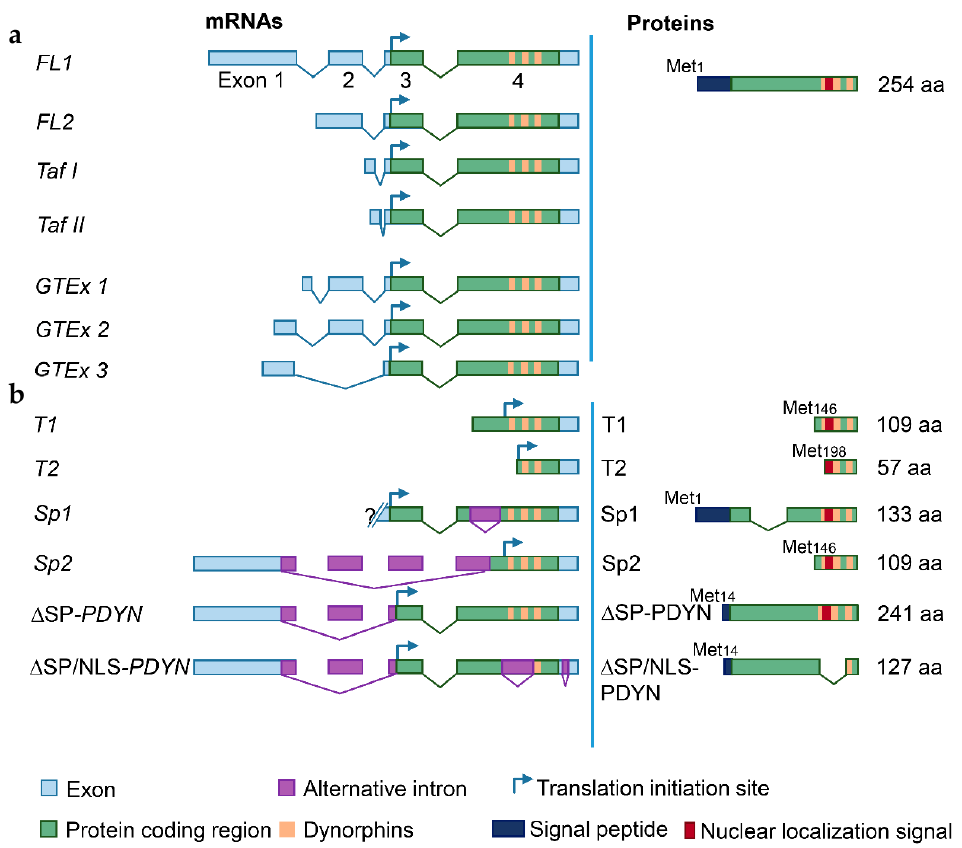
Figure 2. PDYN mRNAs coding for the full-length (FL, ( a )) and truncated proteins ( b ). ( a ) Transcripts encoding FL-PDYN protein. The dominant FL1- PDYN and shorter transcripts including FL2- PDYN and GTEx1-3 and testis-specific Taf I and Taf II transcripts differ in the first and second exons, and in TSS. ( b ) PDYN mRNAs encoding truncated PDYN proteins including alternatively spliced Sp1, Sp2, Δ SP-PDYN and Δ SP/NLS-PDYN transcripts, and transcripts initiated within the coding part of exon 4 (T1 and T2). Signal peptide is truncated in both Δ SP- and Δ SP/NLS-PDYN. Putative nuclear localization signal (NLS) is located in the dynorphin domain. Curved arrows show initiation of translation. Modified from [46].